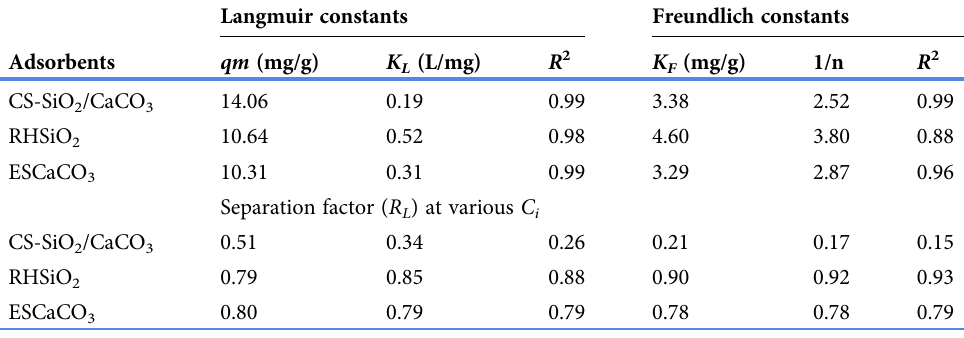
Table 2 Langmuir and Freundlich isotherm constants for adsorption of phenol.